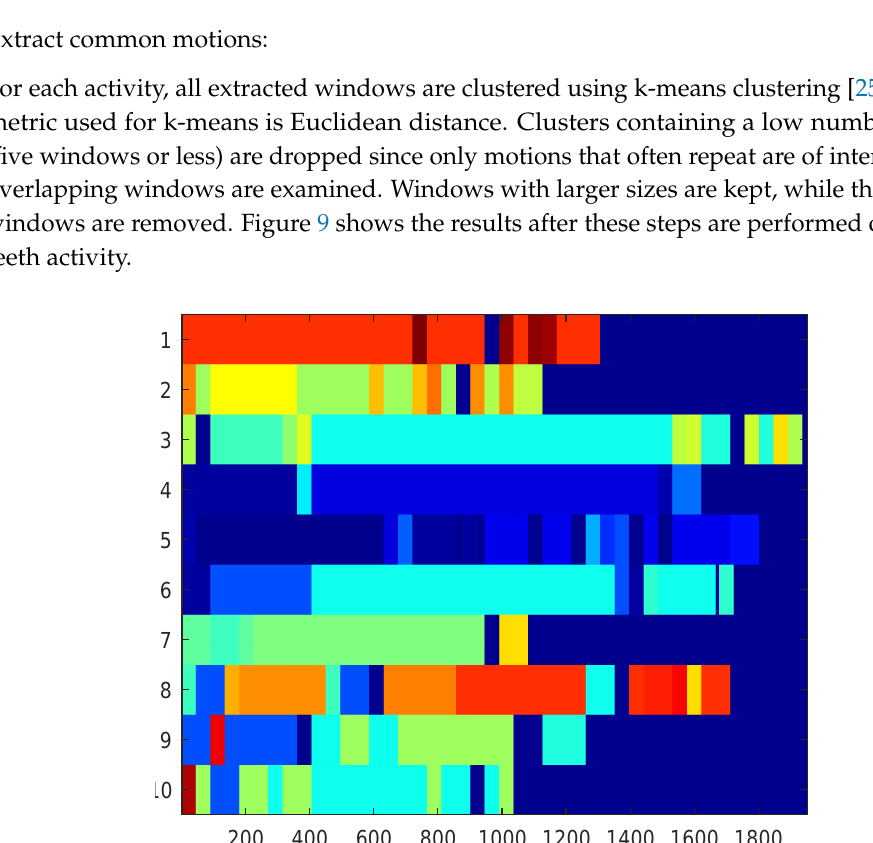
Figure 8. An example showing all windows obtained from a 7-second activity; starting from 0.5-second window segments (top) to the 2-second window segments (bottom), showing the three repetitions (increment of 0%, 25% and 50% of the window size) for each window size.